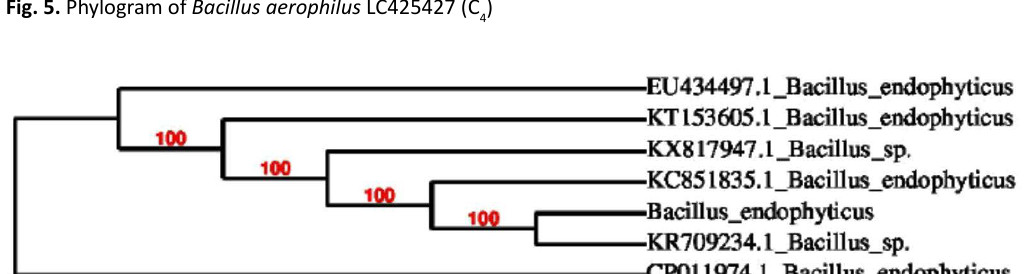
Fig. 5. Phylogram of Bacillus aerophilus LC425427 (C